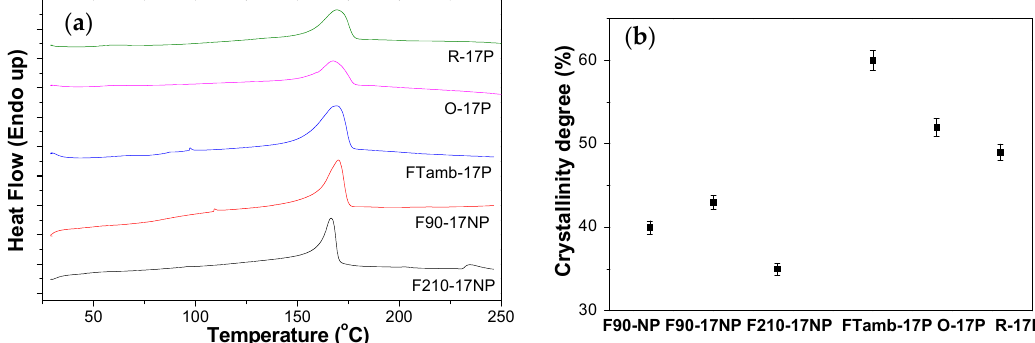
Figure 7. ( a ) DSC thermographs and ( b ) degree of crystallinity of the SiNPs/PVDF nanocomposites with different morphologies and with the fillers of lowest average diameter .